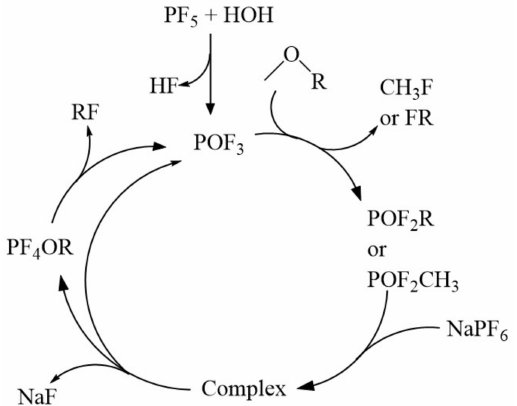
Figure 4. Possible autocatalytic decomposition pathway for NaPF 6 in DME without complexing agents.